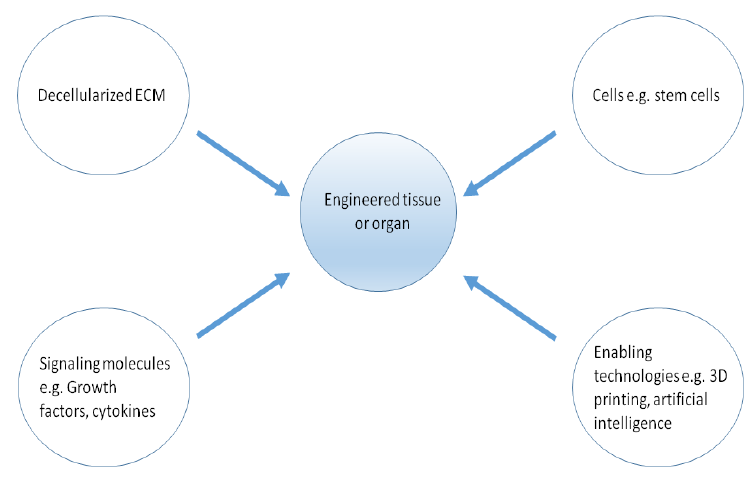
Figure 1. Requirements for engineering of tissues and organs. Decellularized extracellular matrix (dECM), cells, and signaling molecules are mixed in bioreactors in order to initiate tissue or organ formation.